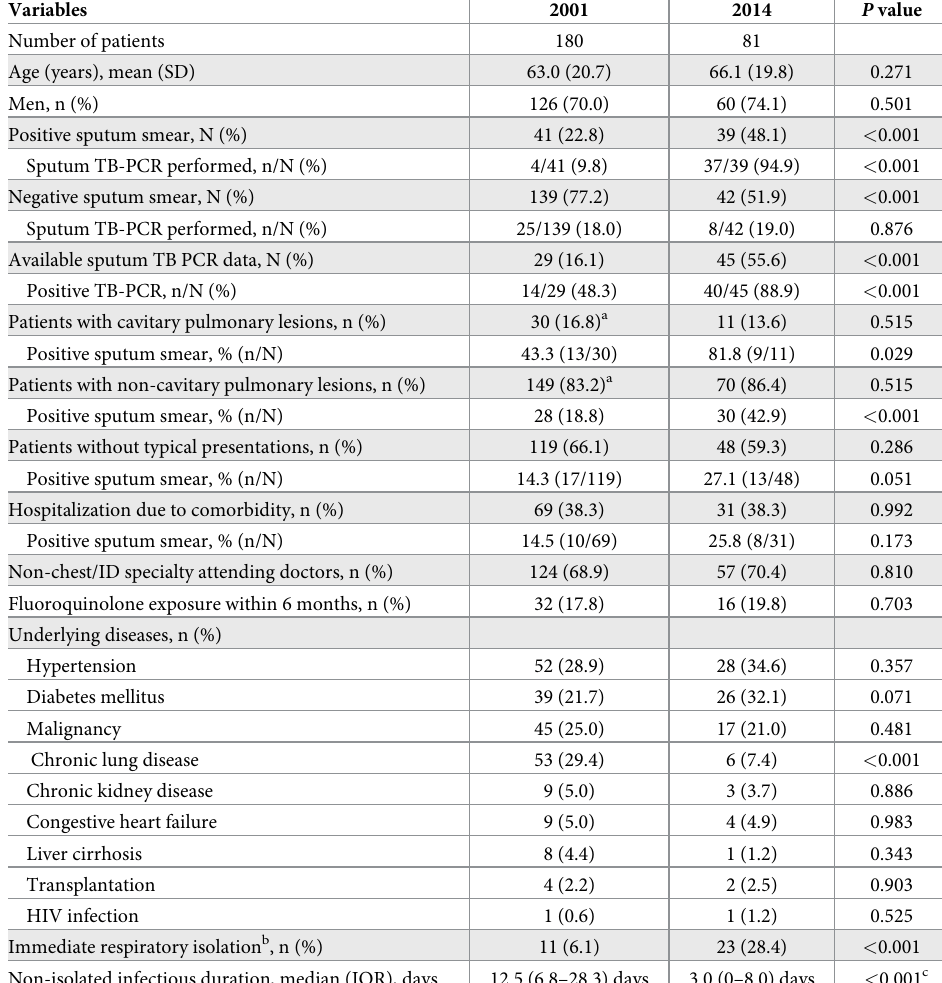
Table 1. Characteristics of hospitalized patients with culture-confirmed pulmonary